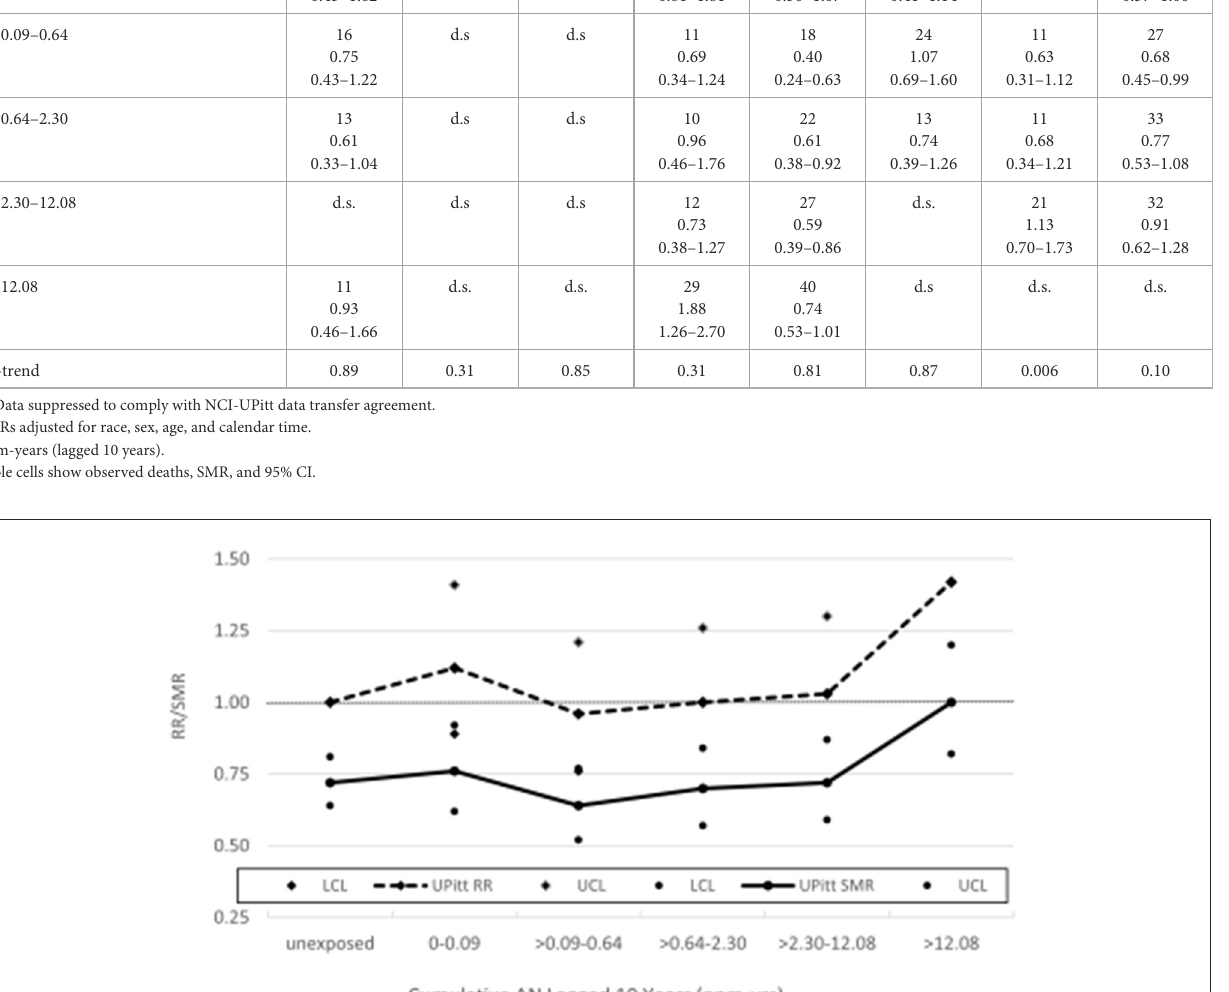
U.S.-based SMR for mesothelioma in the highest cumulative AN exposure category ( > 1.33 ppm-years) decreased from a statistically significant to a nonstatistically significant < 2-fold risk based on regional rates (values not shown due to data